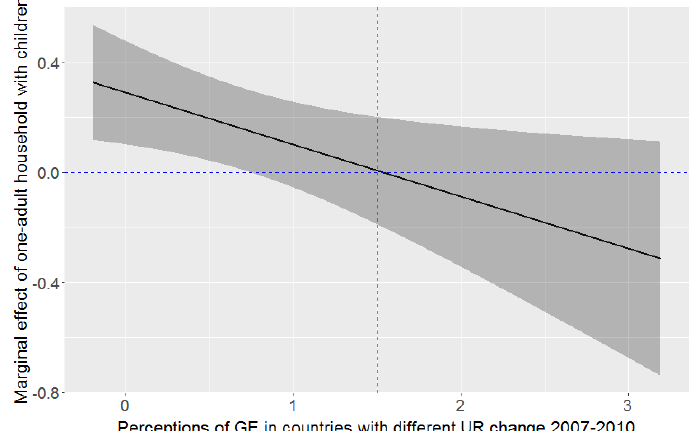
Figure 5. Effect of gender upon perceptions of gender equality in countries with different UR change 2007-